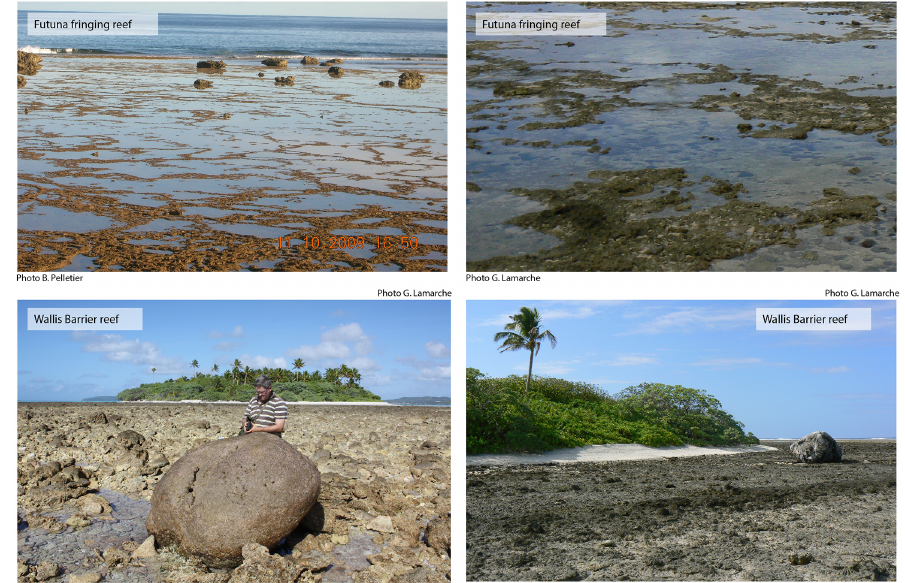
Figure 18. The fringing reef in Futuna (top) and the barrier reef in Wallis (Bottom).